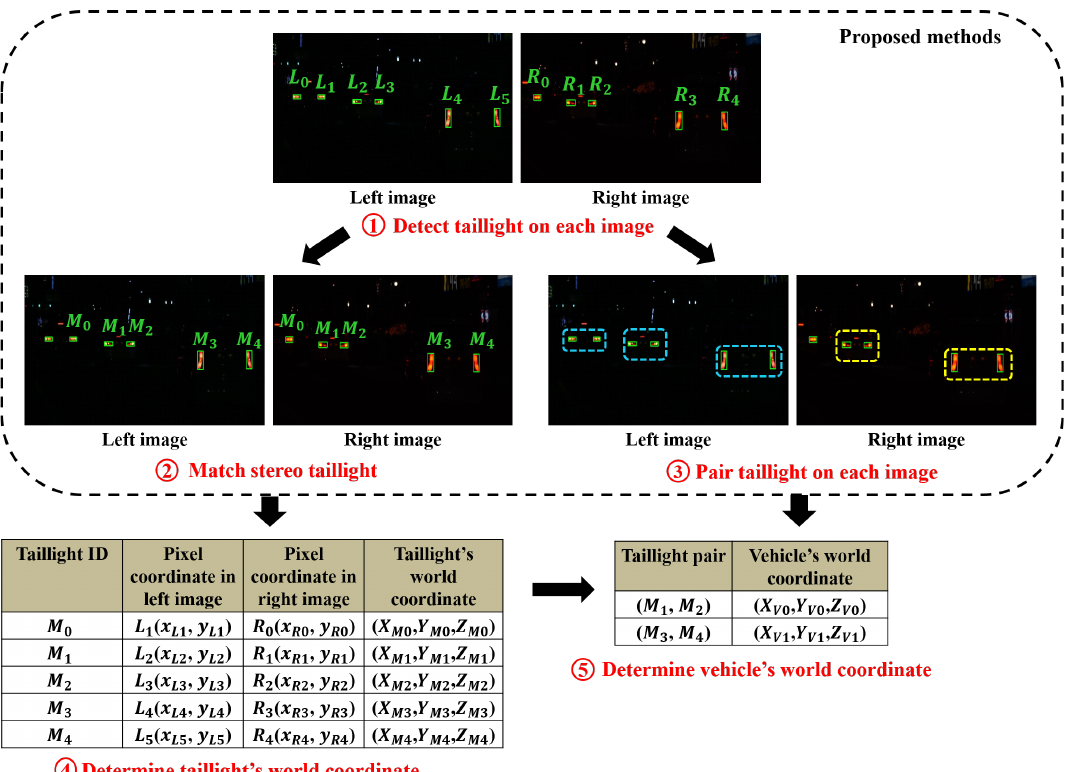
Figure 1. Overview of the stereo-vision-based nighttime V2V positioning